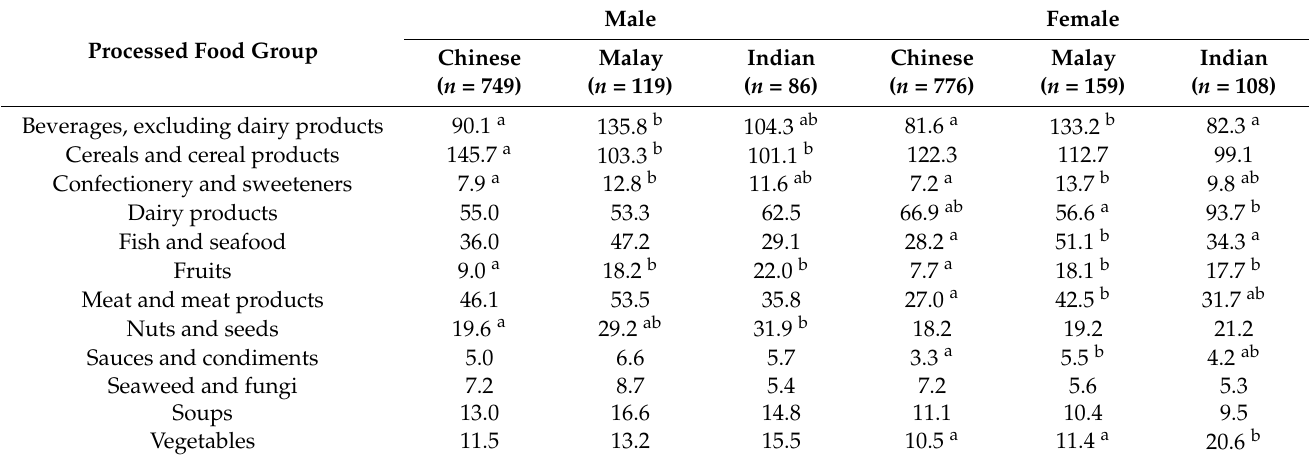
Table 5. Mean daily intake of consumers analysed by gender and ethnic